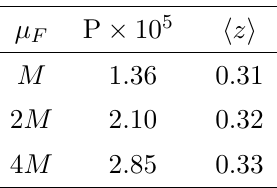
Table 1 . The fragmentation probability and average z value for D g → B factorization scales, where the strong coupling constant is fixed as α s (2 m c ) = 0 . 259 .